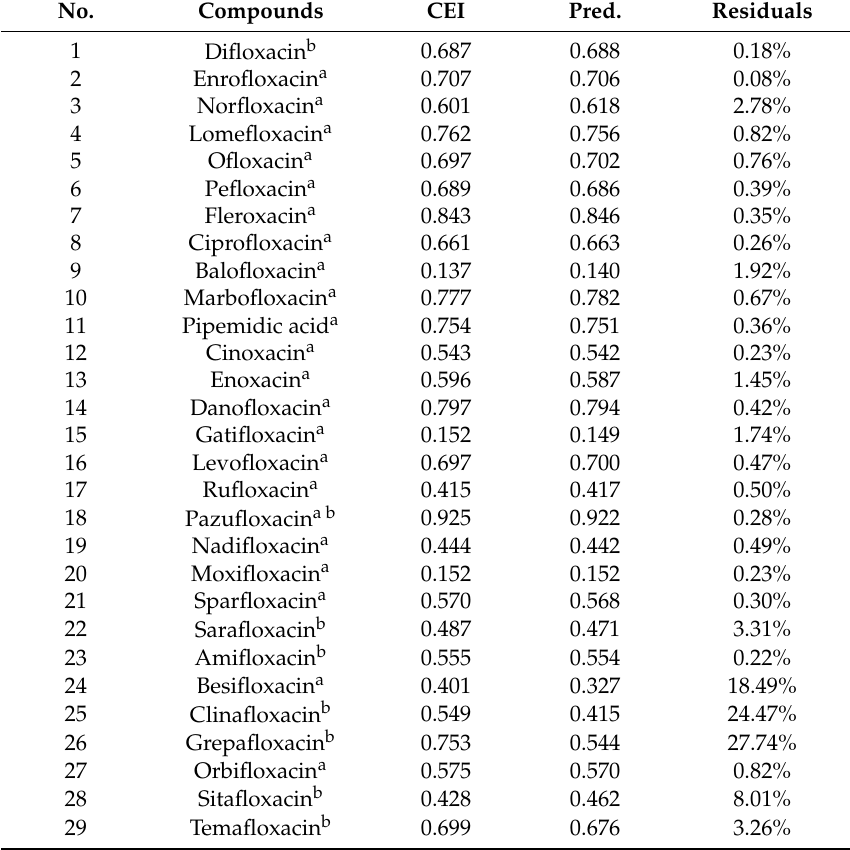
Figure 6. Correlation between experimental values and predicted values of CEI in the CoMFA model. Table 3. Experimental and predicted values of fluoroquinolones through the CoMFA model. No.